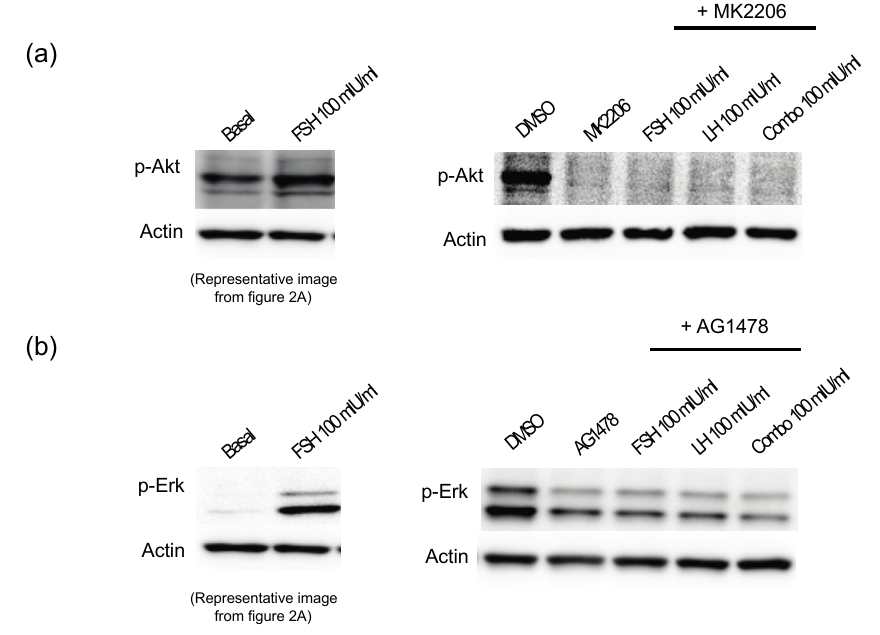
Figure S1. Gonadotropin induced ( a ) p-Akt protein expression in MOSE cells was blocked in presence of an Akt inhibitor, MK-2206 at 5 min while ( b ) p-Erk protein expression was suppressed in presence of EGFR inhibitor, AG1478 at 5 min.